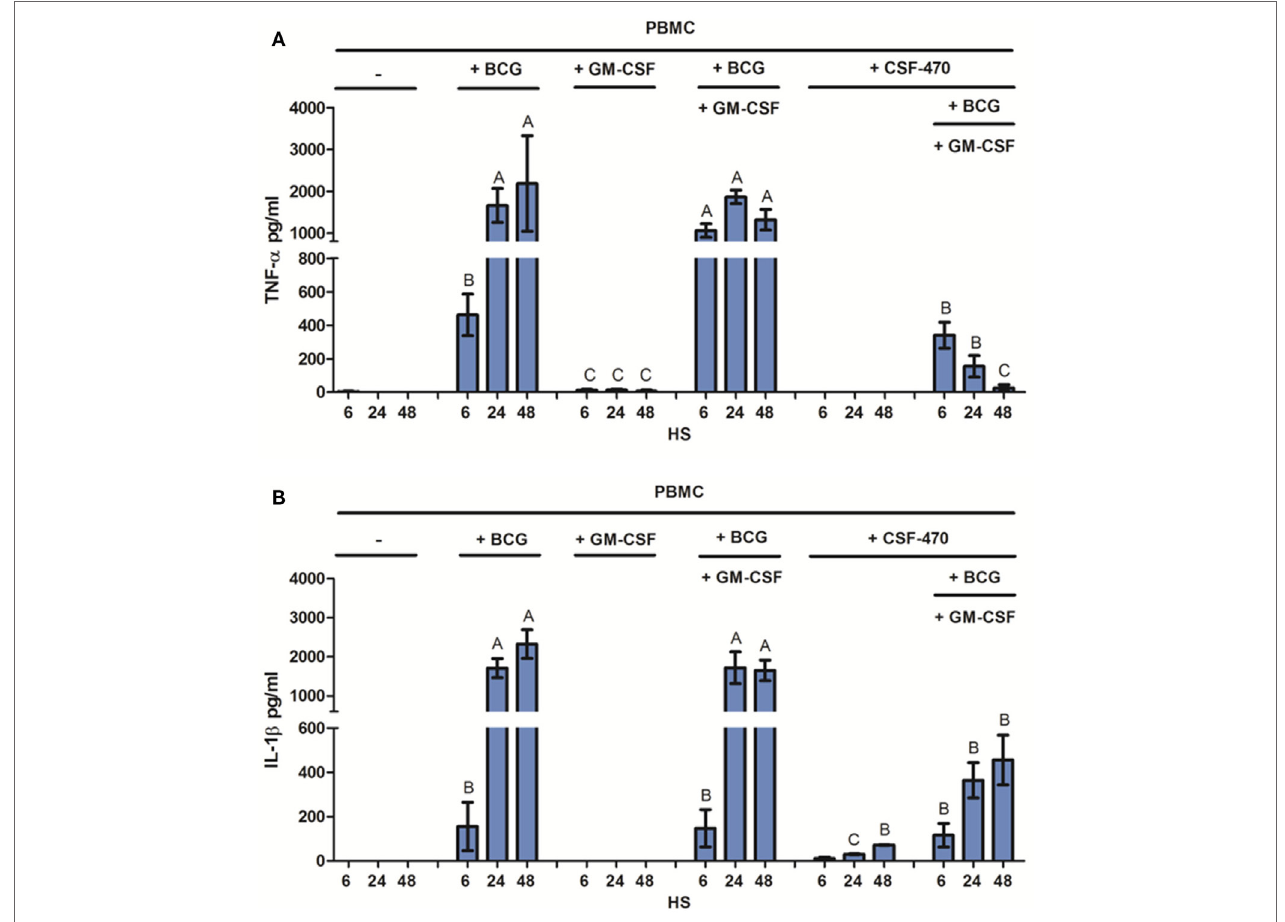
FigUre 4 | Pro-inflammatory cytokines released by peripheral blood mononuclear cell (PBMC) in CSF-470 cocultures with or without adjuvants, after 6, 24, and 48 h. (a) TNF- α released by PBMC, n = 6. (B) IL-1 β released by PBMC, n = 3. Bars with different letters are statistically different ( p <